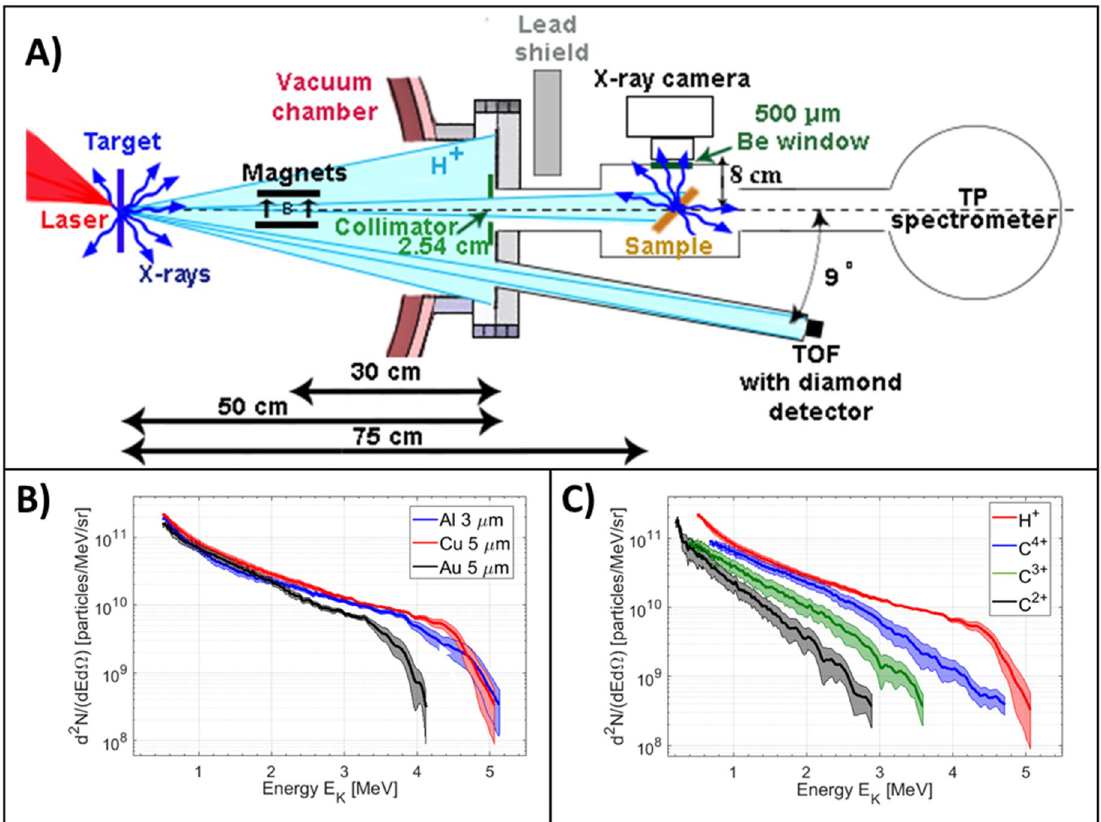
Figure 1. Experimental setup and ion spectra. ( A ) Experimental setup. The interaction of the 100 TW laser with the solid target (left blue) accelerates several types of ions species and generates X-rays. The ions and X-rays propagate under vacuum to the sample (orange right) to be probed, and the ion detectors. The X-rays generated by the sample are analyzed by the X-ray camera. ( B ) Proton energy spectra as accelerated by an Al 3 µm (blue), Cu 5 µm (red) and Au 5 µm (black) thickness targets, measured by the Thomson Parabola (TP) spectrometer equipped with a MicroChannel Plate (MCP) located at 0°. ( C ) Particle spectra as accelerated by a Cu 5 µm thickness target for different laser-accelerated ion species (H + in red, C 4+ in blue, C 3+ in green, and C 2+ in black as obtained by the TP spectrometer. Each spectrum is averaged over 10 shots and the uncertainties are calculated using the standard error of the interaction 34 . A 250 µm thickness Be window of diameter 5.08 cm, which allows the transmission of 90% of X-rays with 8 keV energy, was used to keep the camera in vacuum, protect it from visible light and reduce the background signal. An identical window was used to keep the vacuum in the auxiliary chamber. Different ion diagnostics were used: a Thomson Parabola (TP) spectrometer, located at 0° with respect to the ion axis, equipped with a MicroChannel Plate (MCP), as well as a Time-of-Flight (TOF) delay line equipped with a diamond detector positioned at 9° 35 . This setup was allowing the sample to be inserted (or not) inside the auxiliary chamber before every shot using gate-valve isolations along with an independent pumping system. This allowed to use either the TP or the XPIF setup on the 0° axis within a few minutes of pumping time. Typical averaged ion spectra with their uncertainties, as obtained with the employed targets and measured using the 0° TP spectrometer are displayed in Fig. 1B exhibiting maximum proton energy of about 5.0 ± 0.5 MeV for the Cu and Al interaction target, 4.0 ± 0.5 MeV for the Au interaction target, and a mean integrated proton yield of about 2.0 × 10 11 protons/sr with a statistical (shot-to-shot) fluctuation of 15% in the central section of the spectrum around 3 MeV, as measured over 10 shots in an identical configuration. We employed simultaneously the TOF and TP when measuring the proton spectra. This configuration allowed to cross-calibrate the two diagnostic systems 36 and to relate the proton spectra measured at 9° by the TOF line with the one measured at 0° by the TP spectrometer. With this configuration, we could measure indirectly the main on-axis characteristics of the proton beam impinging on the target, shot-by-shot and in real-time, even if the sample was blocking the TP spectrometer. Concerning the other main ion species (C 4+ , C 3+ and C 2+ ) simultaneously accelerated by TNSA mechanism (see Fig. 1C), we find an integrated particle number of 8.0 × 10 10 particles/sr for C 4+ , 6.4 × 10 10 particles/sr for C 3+ and 3.9 × 10 10 particles/sr for C 2+ , all of them with a statistical fluctuation of 55%. To estimate the contribution of these heavy ions compared to protons in the PIXE process, we use the Monte Carlo simulation code called Geant4 37 , a reference toolkit for the simulation of the passage of particles through matter. The results show that